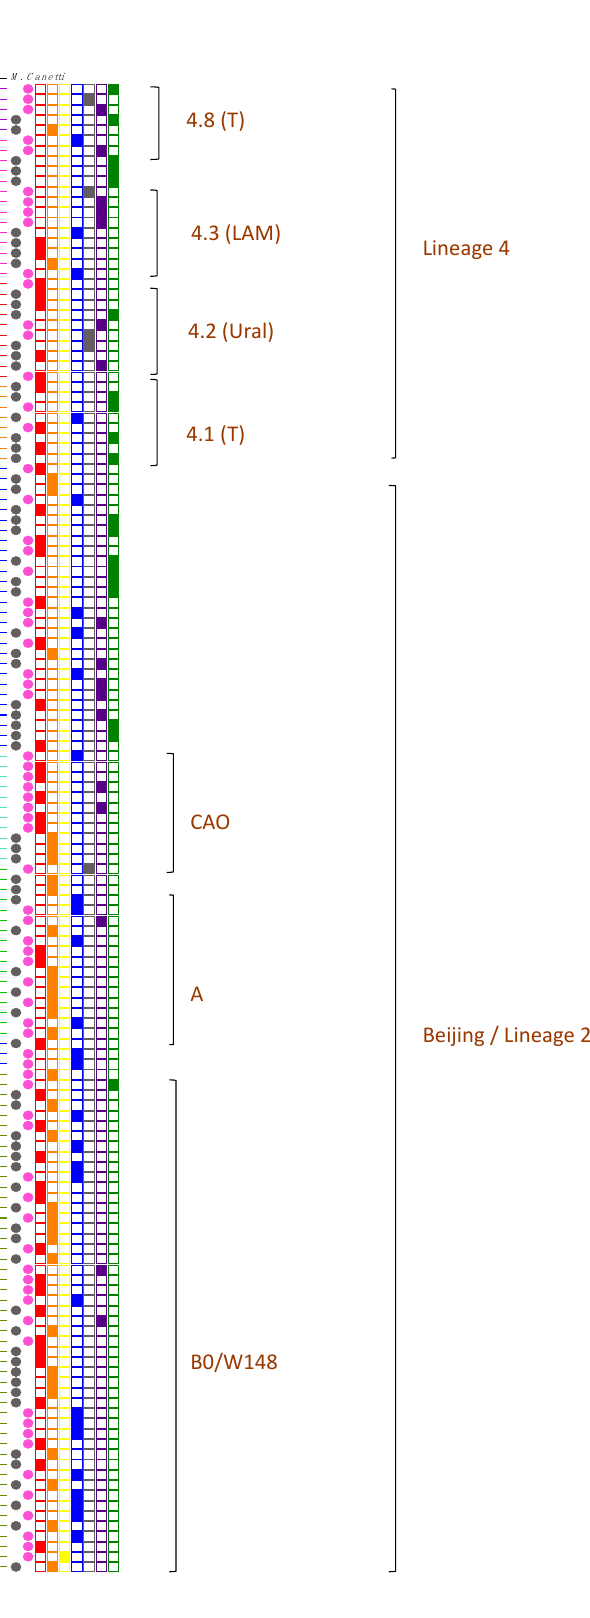
Figure 1. Phylogenetic analysis of M. tuberculosis isolates obtained from patients with pulmonary tuberculosis (PTB) and extra-pulmonary tuberculosis